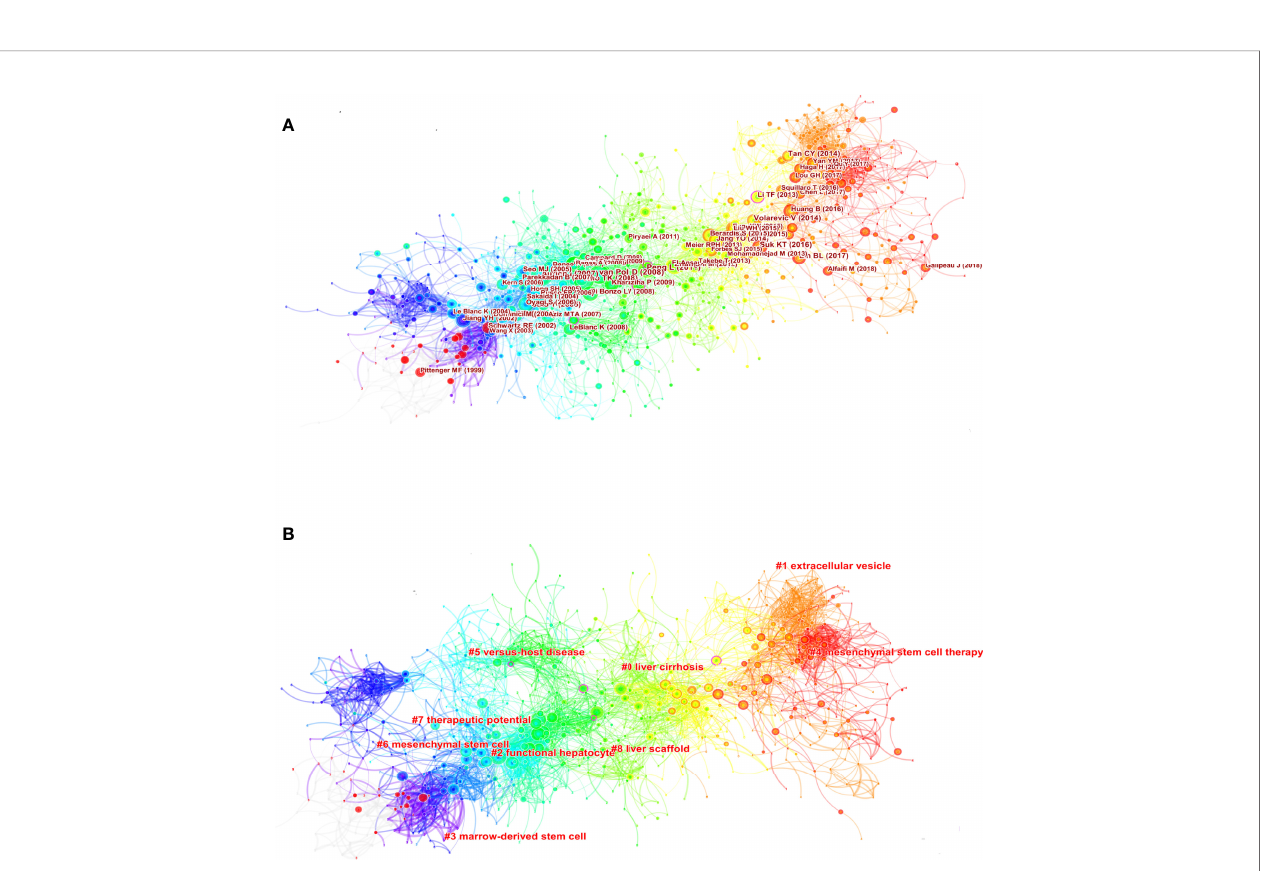
FIGURE 7 | Visual analysis of co-citation (A) and clustering network (B) . The nodes in the fi gure represent the co-citation literature, and the links between nodes represent the co-citation relationship. Large nodes or nodes with red tree rings are either highly referenced or erupted. All cluster labels were extracted from titles of citing articles using the log-likelihood ratio algorithm.